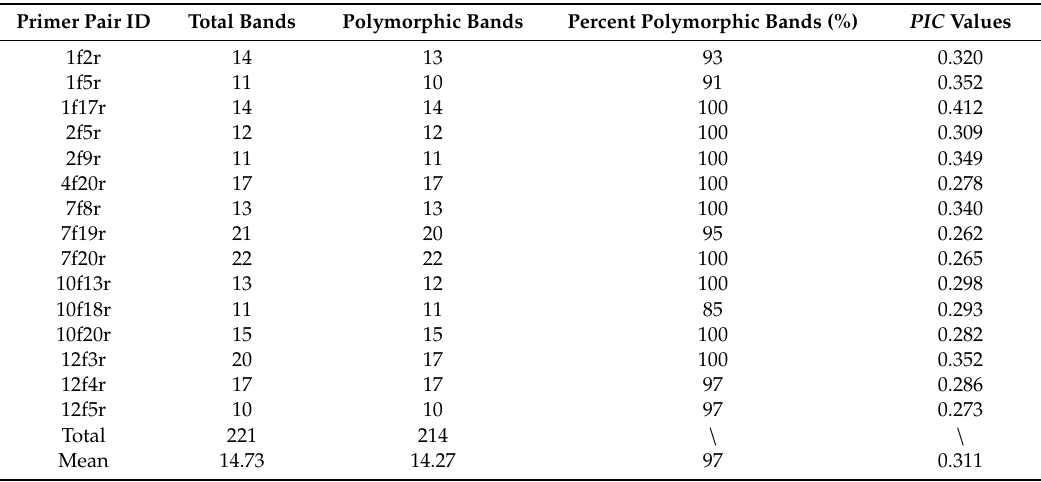
Table 2. Amplification results of 7 populations in the genus Megalobrama at 15 sequence-related amplified polymorphism (SRAP) loci. PIC: polymorphism information